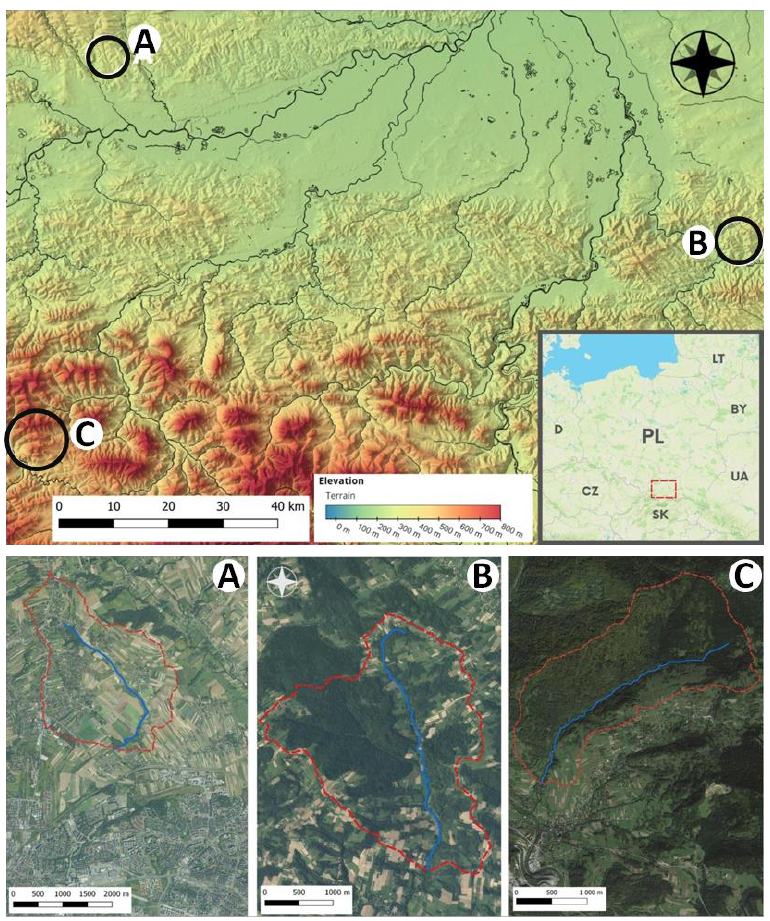
Figure 1. Location of the research area and boundaries of the examined catchments (( A ) — urban; ( B ) — suburban; ( C ) — rural).